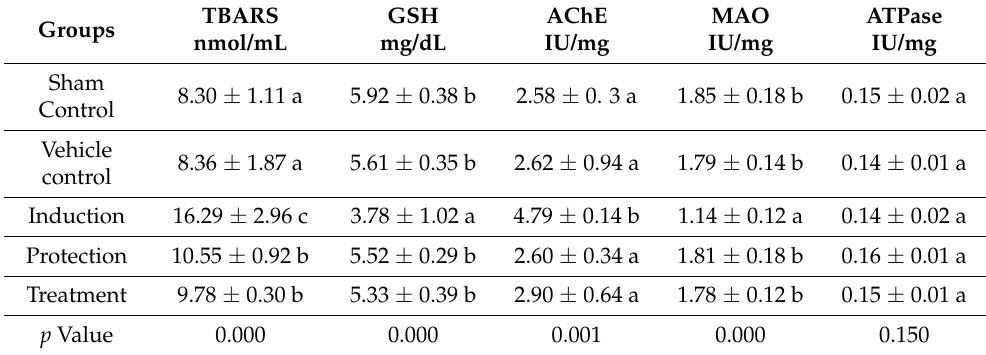
Table 5. Effect of different treatments on serum oxidative stress marker (TBARS and GSH), neurotransmitter-catabolizing enzyme (AChE and MAO), and ATPase activities. Groups